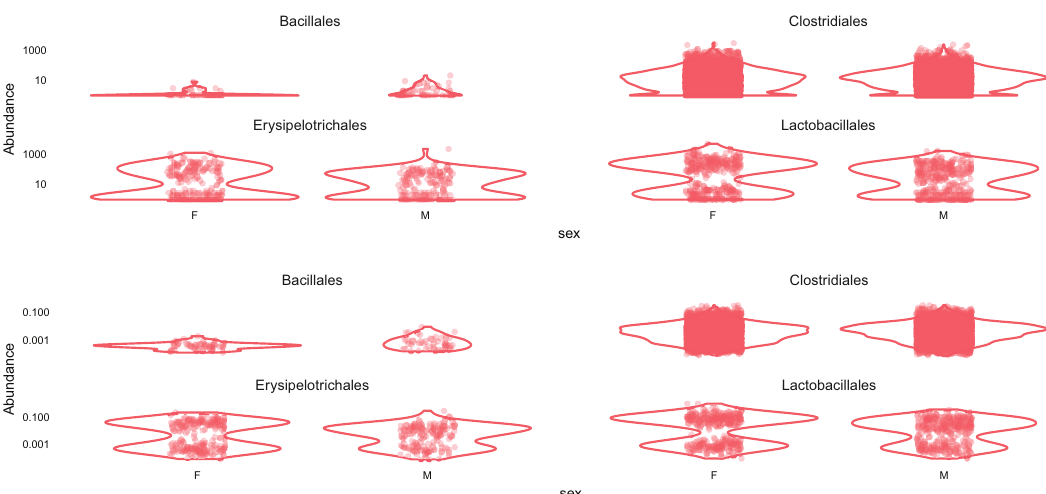
Figure 5. Comparison of original abundances (top panel) and relative abundances